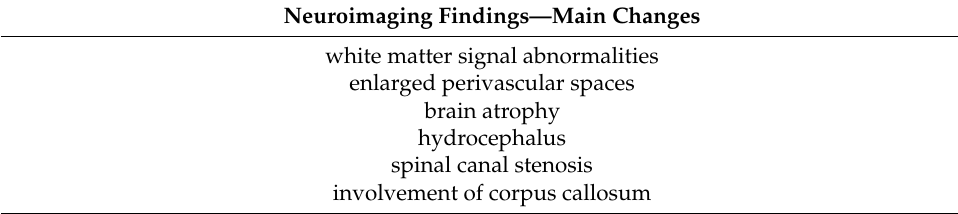
Table 3. CNS imaging features.